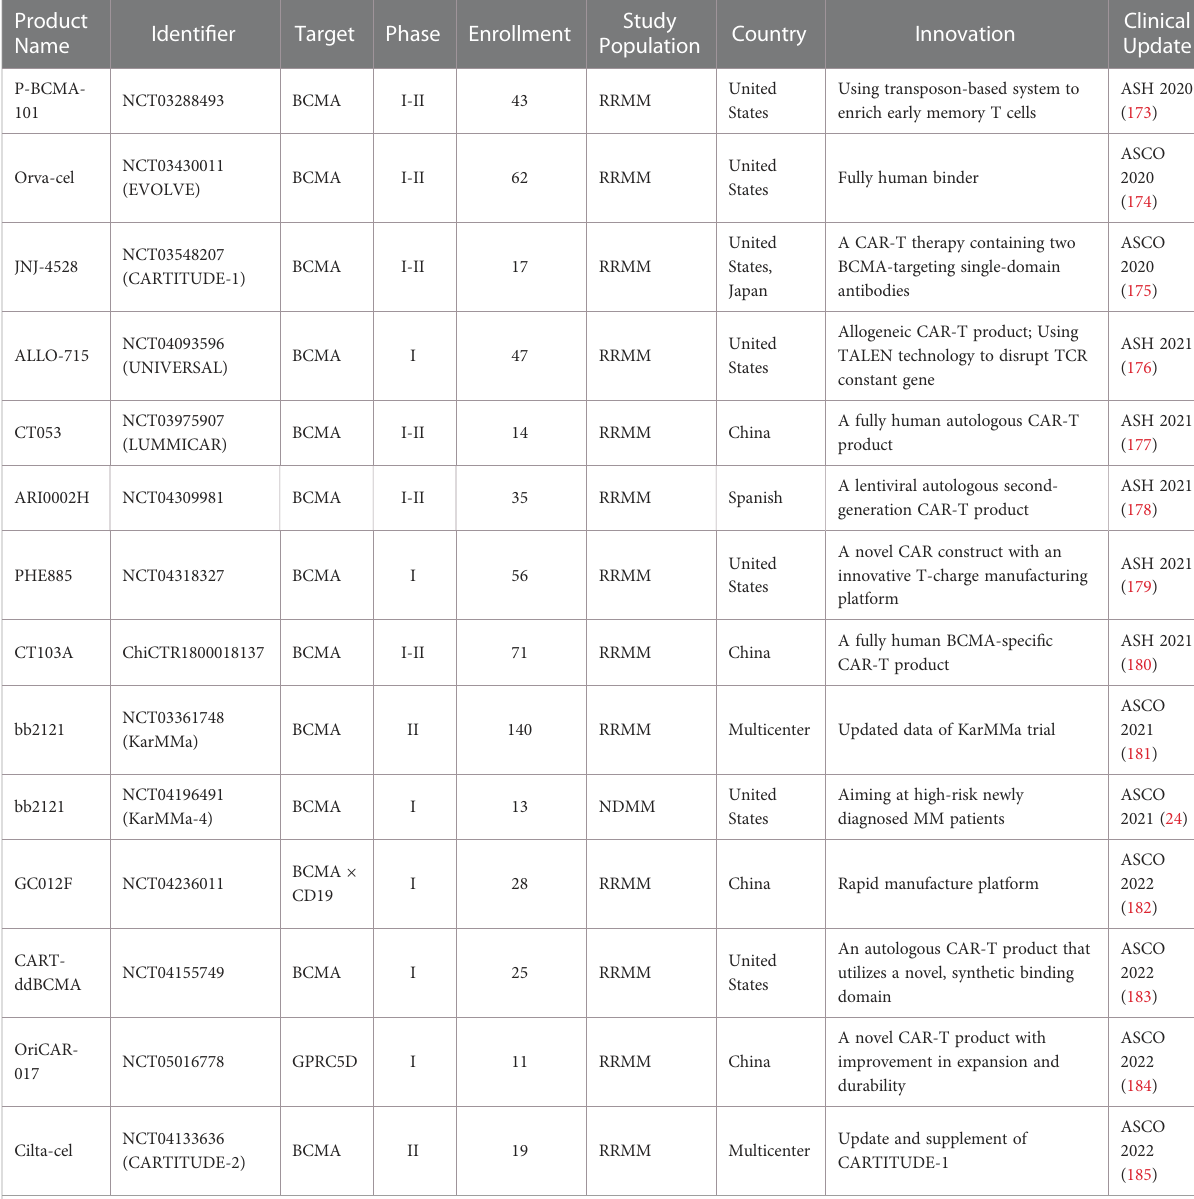
TABLE 5 Clinical trials of novel therapeutic agents for MM at recent oncology meetings,